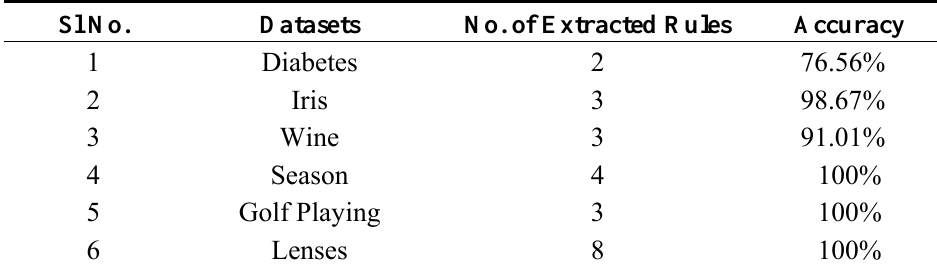
Table 9. Number of extracted rules and rules